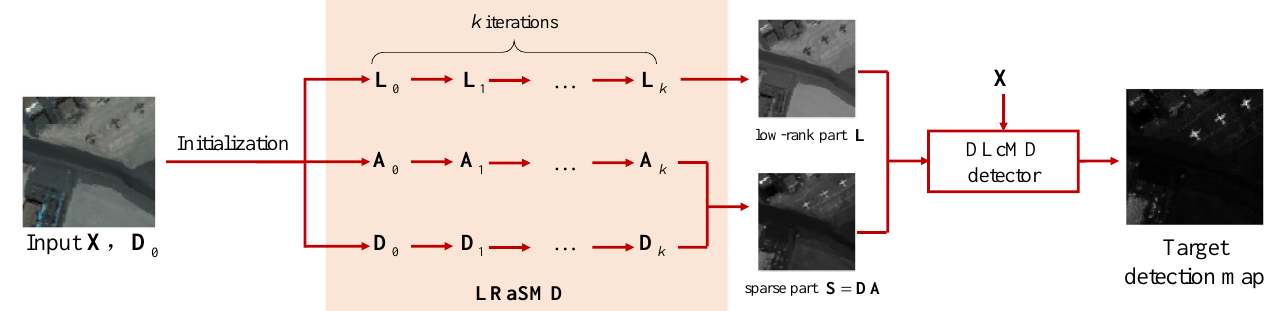
Figure 2. Flowchart of the proposed